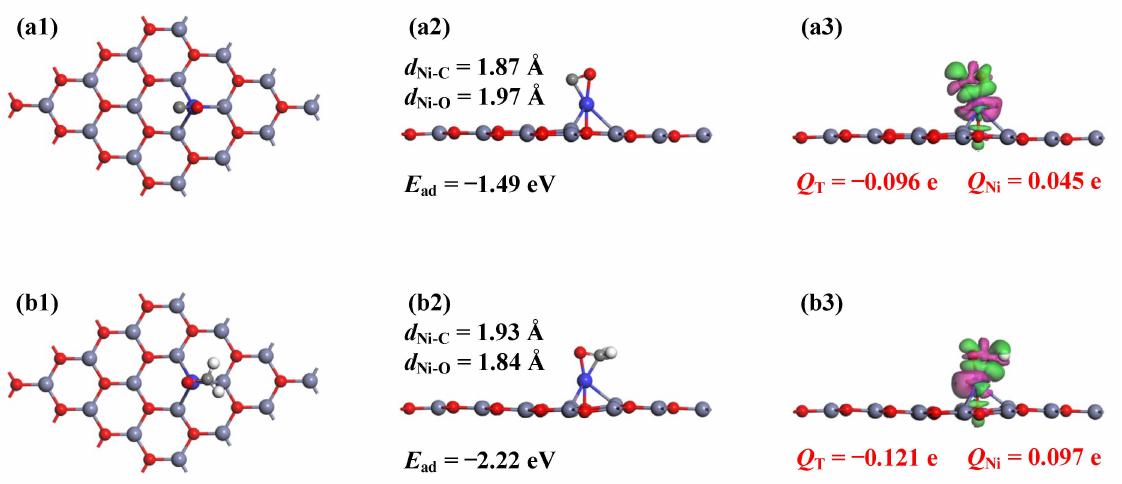
Figure 3. MSC and CDD of ( a1 – a3 ) HCHO system and ( b1 – b3 ) C 2 H 3 Cl system. In the CDD, the definitions are the same as Figure